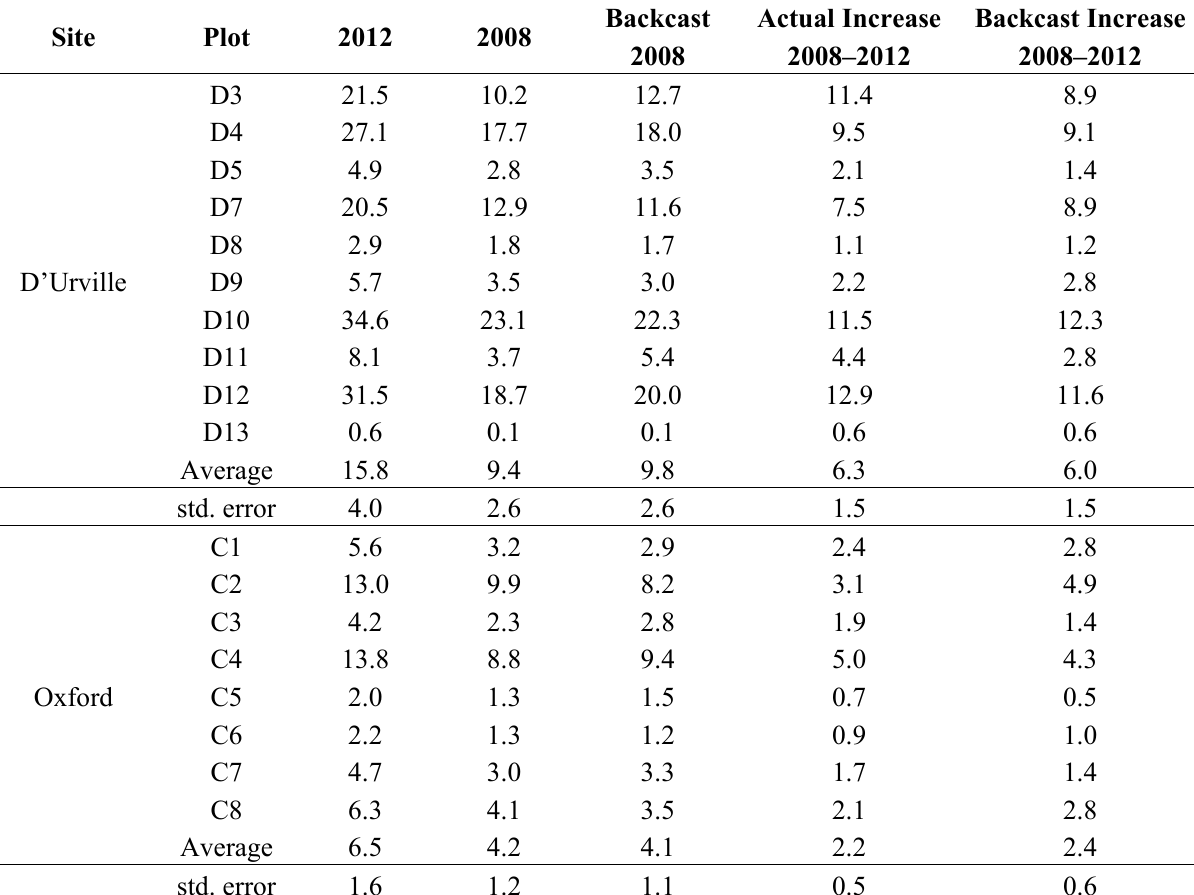
Table 4. Estimated carbon stock (t/ha) of above-ground live biomass carbon in 2012, 2008, and backcast estimates for 2008, along with actual and backcast estimates of carbon change between 2008 and 2012. Values are for plants measured for diameter and height in both 2008 and